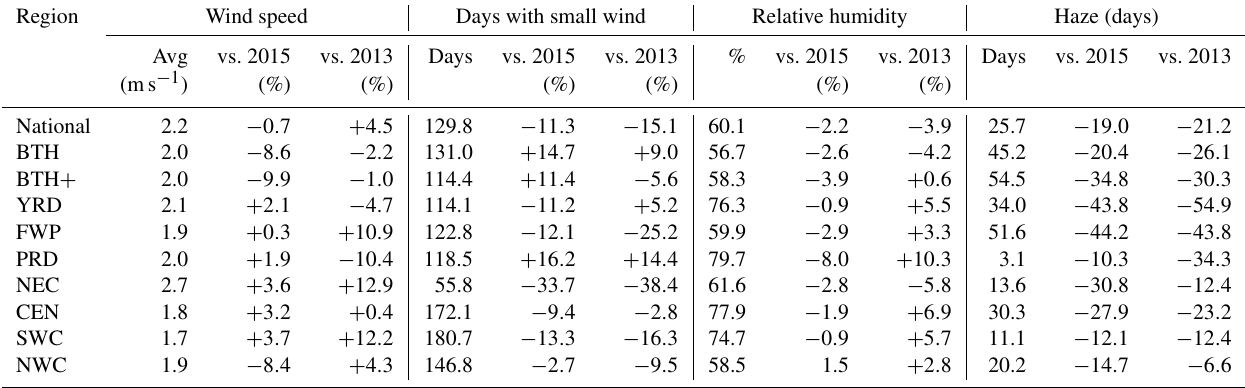
Table 1. National and regional environmental meteorology in 2019 and comparisons with 2015 and 2013. Region Wind speed Days with small wind Relative